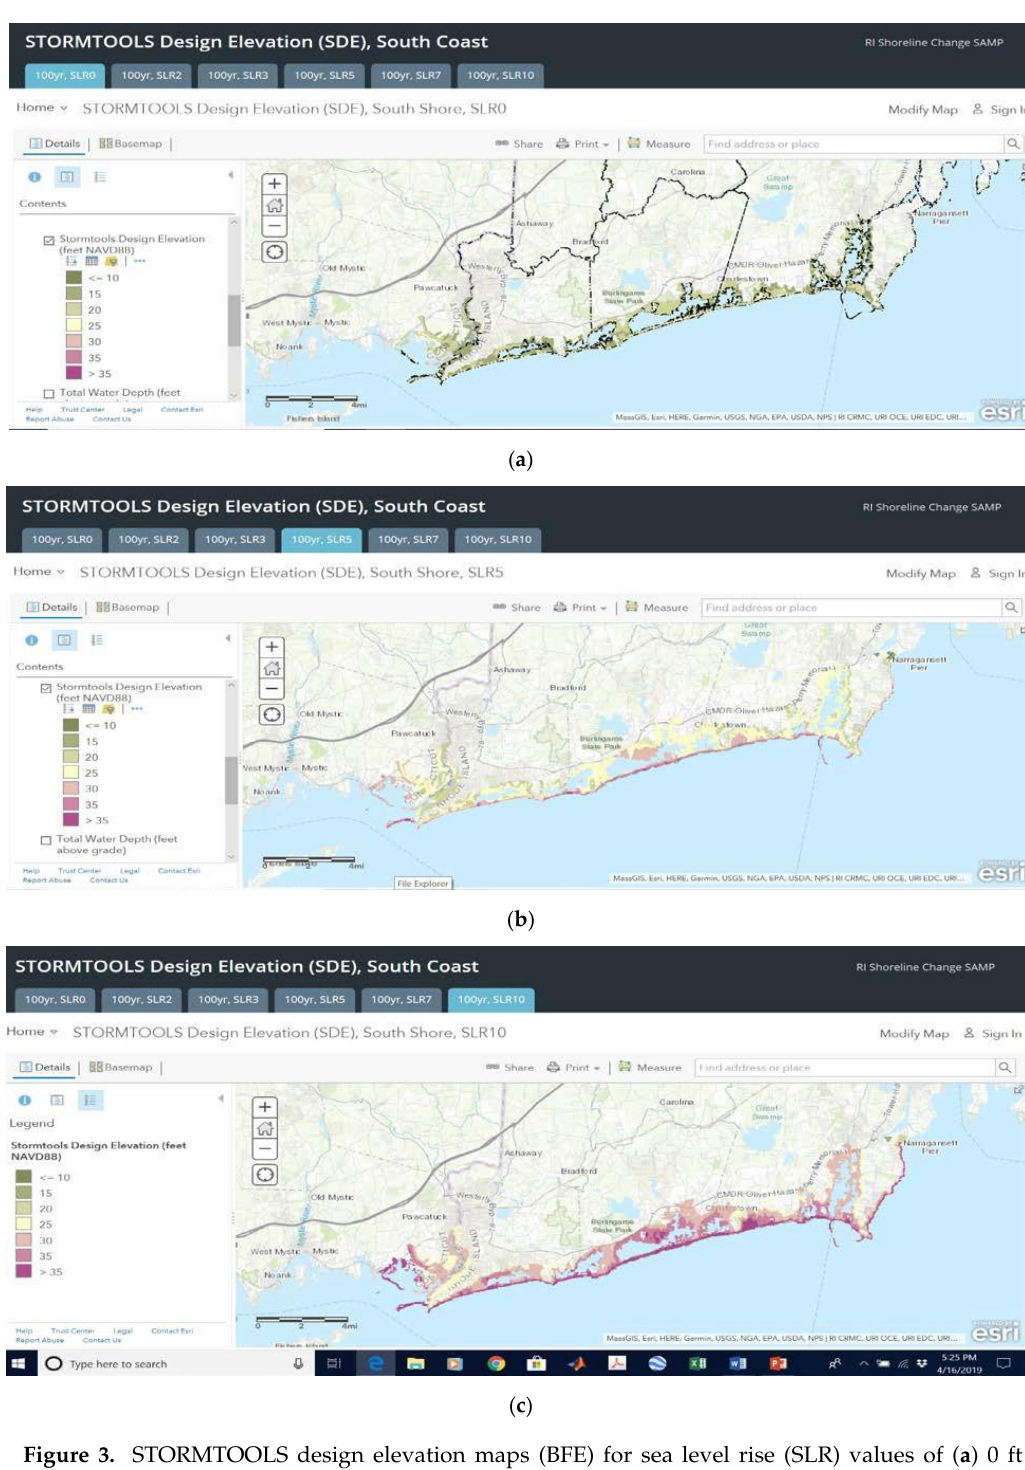
Figure 3. STORMTOOLS design elevation maps (BFE) for sea level rise (SLR) values of ( a ) 0 ft (upper panel), ( b ) 5 ft (middle panel) and ( c ) 10 ft (lower panel). Blue colored tabs at the top of each figure show the SLR value selected. The BFE values are provided in feet relative to NAVD88. The legend for each figure is shown at the left and is the same for all figures to facilitate inter-comparison. The SDE maps and supporting training material to facilitate their use are provided at http: // www. beachsamp.org / stormtools-design-elevation-sde-maps / , accessed on 13 February 2020) The maps for Southern RI are available at: https: // crc-uri.maps.arcgis.com / apps / MapSeries / index.html?appid